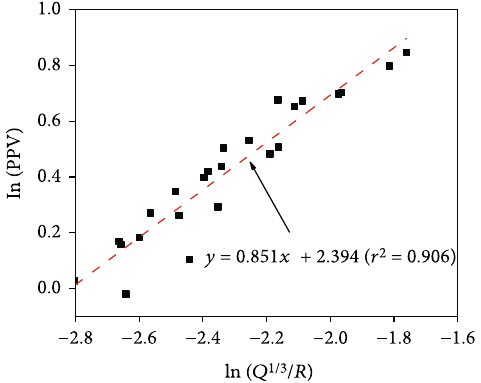
Figure 6: Fitting curve of the blasting vibration velocity.